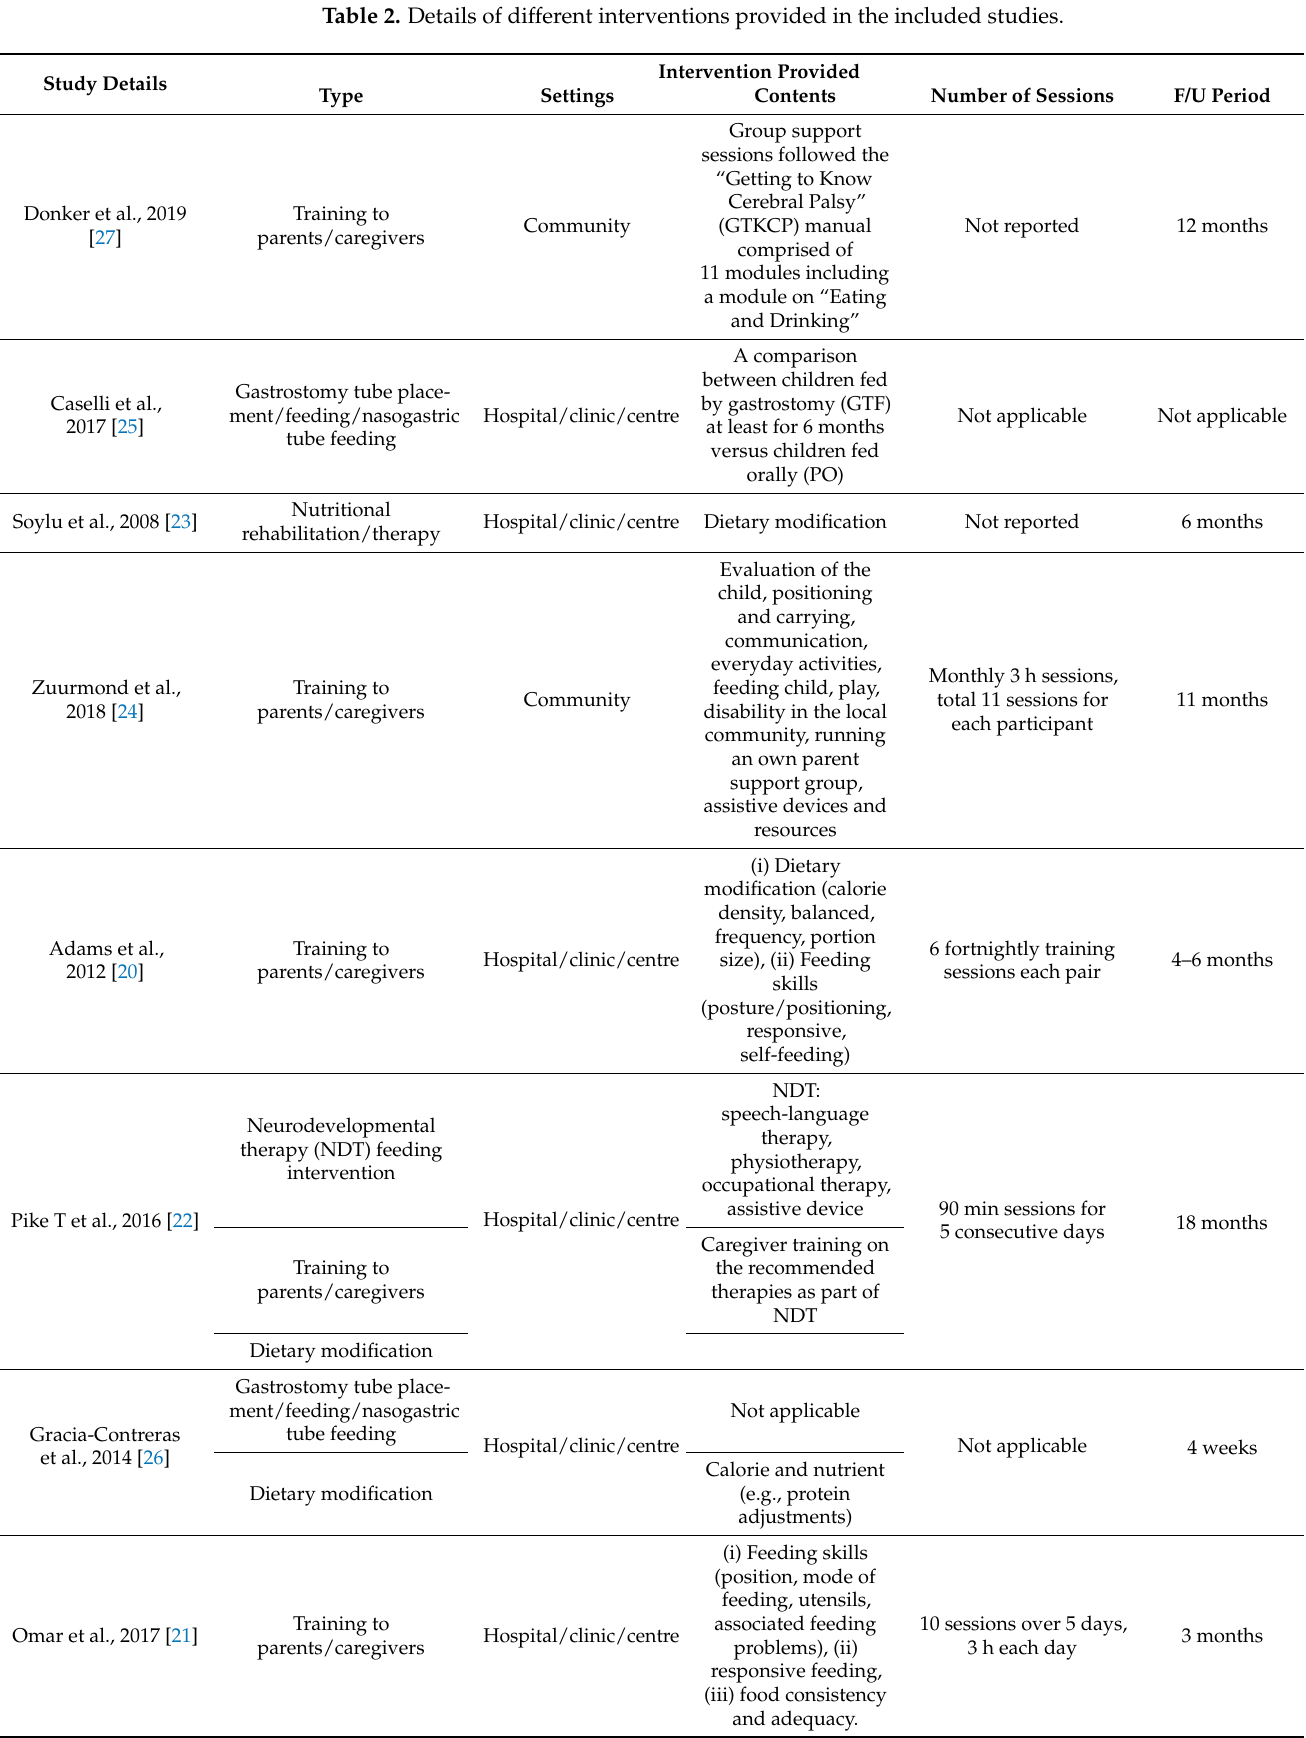
Table 2. Details of different interventions provided in the included